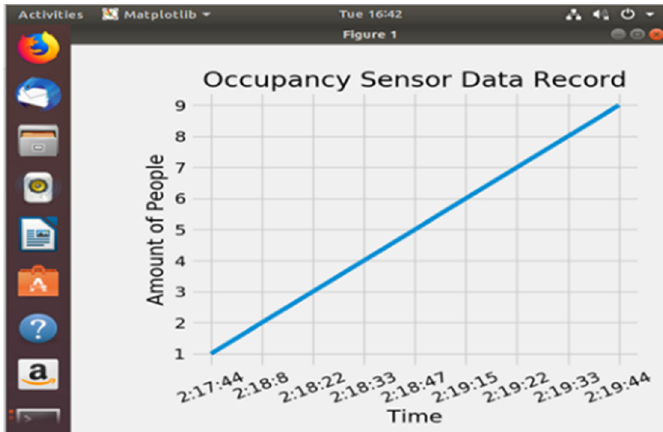
Figure 5. The results in the server (showing the total number of occupants).